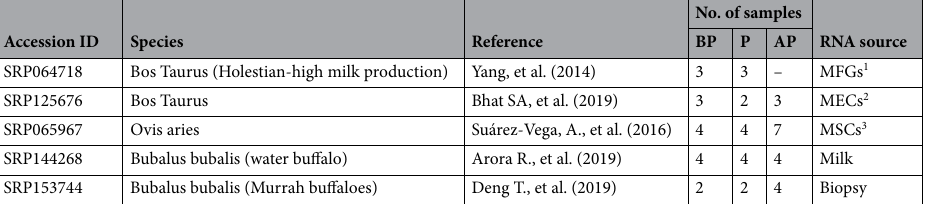
Table 4. Data set ID, species, and number of samples selected for meta-analysis. 1 MFGs = milk fat globules. 2 Mammary epithelial cells = MECs. 3 Milk Somatic Cells =